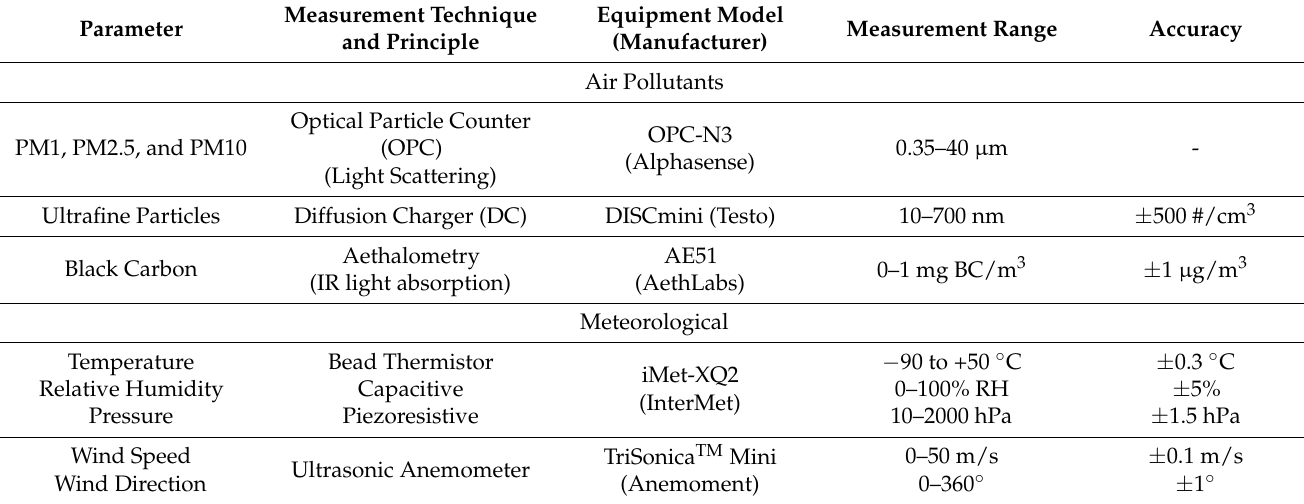
Table 1. Characteristics of the selected portable sensors and